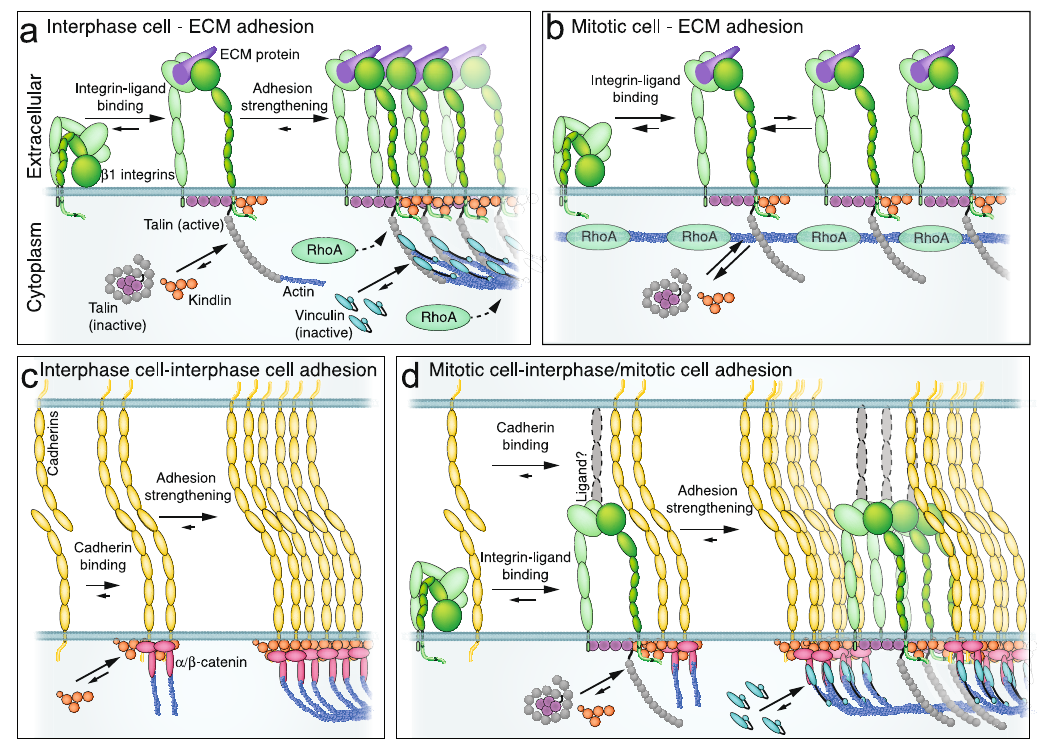
Fig. 9 | Mitotic cells drastically reduce integrin-mediated cell – ECM adhesion andemployintegrinsandadhesomeproteinstostrengthencell – celladhesion. a In interphase, integrins rapidly bind ECM ligands and recruit kindlin and talin, which both connect integrins during adhesion strengthening to the contractile actomyosincortex.Duringintegrinclustering,vinculinisrecruitedtotheadhesion site and reinforces the integrin-actin connection by binding to talin and actin. b Mitotic cells initiate integrin-mediated adhesion to the ECM similarly to inter- phase cells, which depends on kindlin and the talin1-head domain. However,